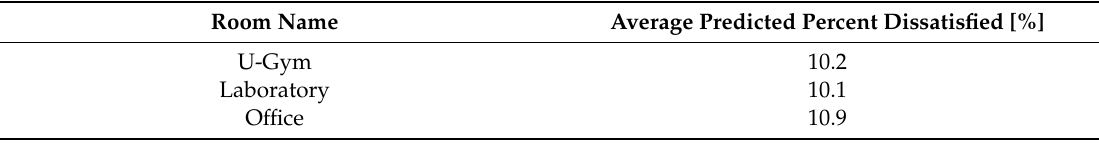
Table 3. Discomfort indicator